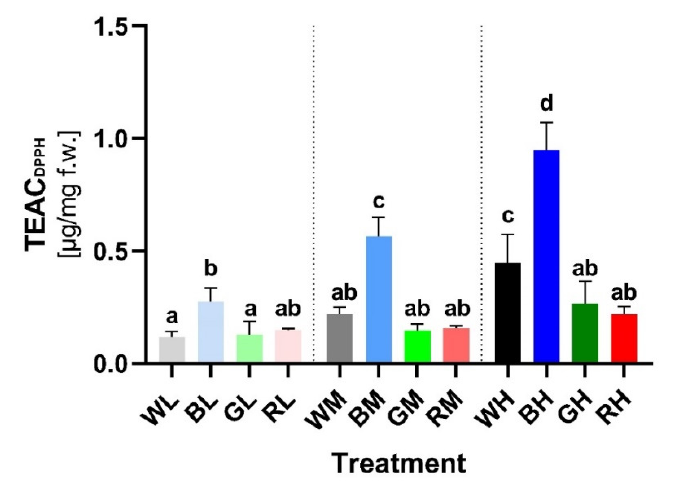
Figure 7. Antioxidant activity of soluble PheCs in secondary leaf extracts of Hordeum vulgare L. cv. Bojos acclimated to light conditions varying in irradiance and spectral qualities, expressed as a TEAC (Trolox-equivalent antioxidant capacity). Antioxidant activity was determined by colorimetric assay using 2,2-Diphenyl-1-picrylhydrazil stable radical (for details see Section 4.6). Specifications of light treatments: W (white), B (blue), R (red), G (green), L (low irradiance, 100 µ mol m − 2 s − 1 ), M (medium irradiance, 200 µ mol m − 2 s 1 ), and H (high irradiance, 400 µ mol m − 2 s − 1 ); n = 5–6 ± SD. Treatments marked above with same letters did not significantly differ based on Tukey’s post-hoc test.